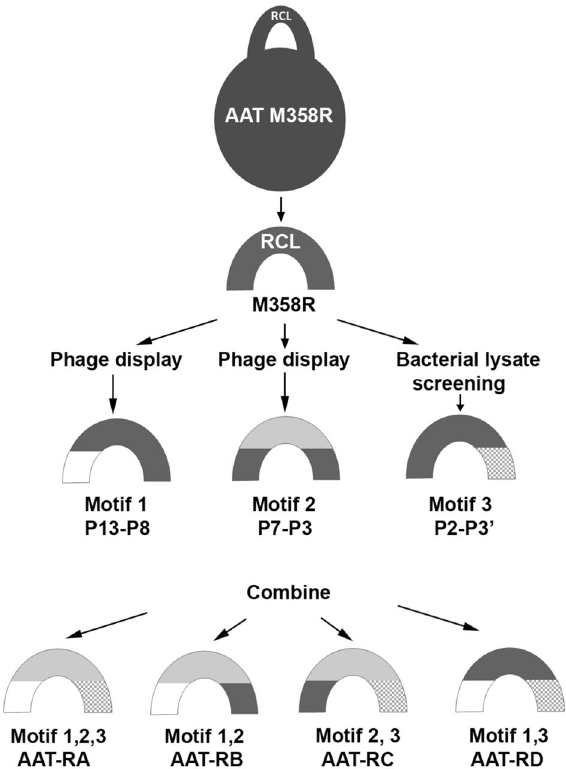
Figure 1. Schematic diagram of screening and mutagenesis approaches used in this study. “Kettle ball” diagram of AAT M358R shows the body of the serpin (circle) with a protruding reactive centre loop (RCL, black). P13-P8 (with P12 fixed as A353) residues were probed by biopanning an AAT phage display library randomized at these positions with FXIa to select the most active Motif 1 (white). Similarly, P7-P3 residues